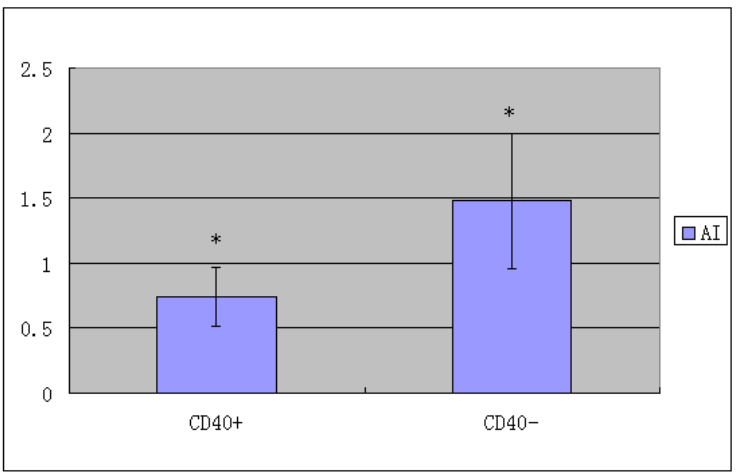
Figure 4. Correlation of CD40 expression with apoptotic index (AI) in gastric cancer tissues, *P < 0.05.